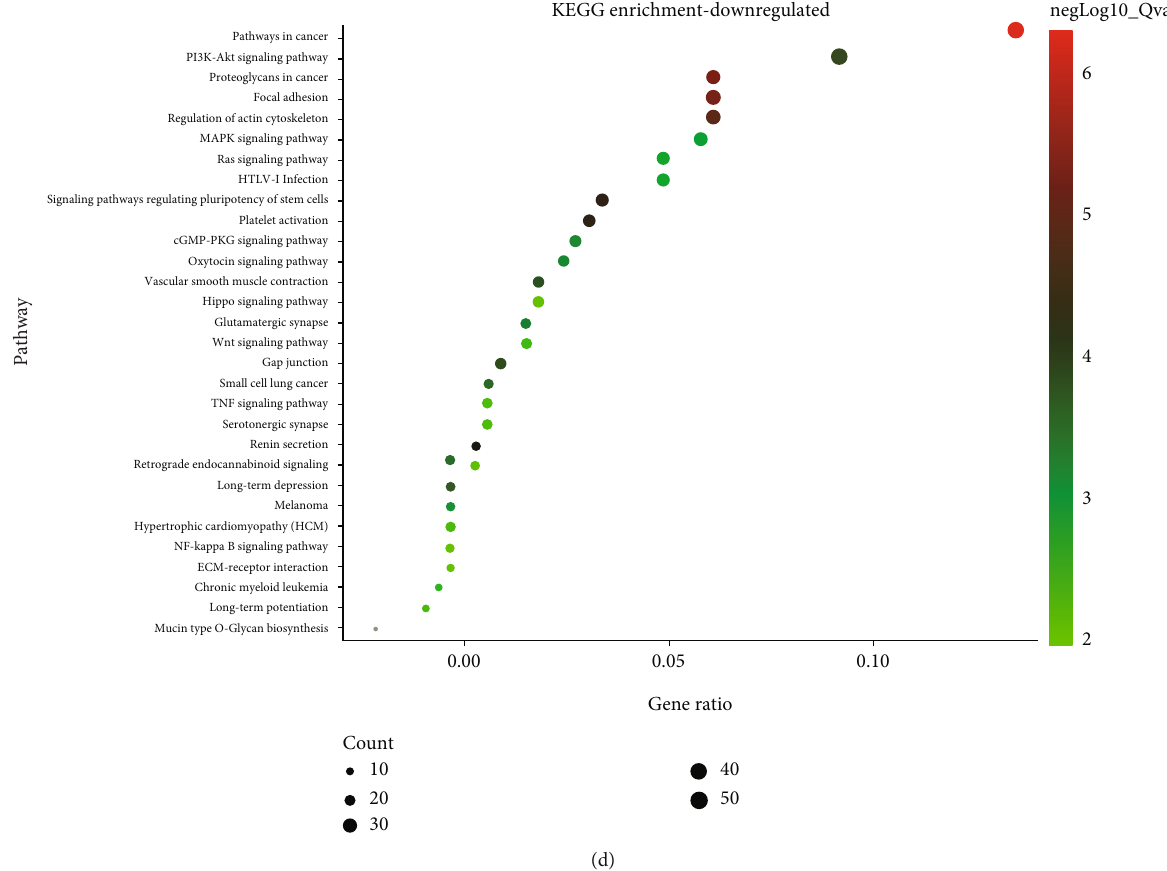
Figure 1: Functional enrichment of 1562 DEGs in lgCMN. (a) Volcano plot of DEGs. The red dots represent the upregulated genes, whereas the green dots represent the downregulated genes. The gray dots are genes without signi fi cant di ff erence in expression. Line threshold: Log ∣ FC ∣ >2 and adjusted P value < 0.05. (b) Gene Ontology enrichment of DEGs. (c and d) Top 30 signi fi cantly enriched pathways of downregulated and total DEGs demonstrated as bubble charts. The size of the bubble illustrates the gene count in each pathway, and the color symbolizes the enrichment degree. A Q value < 0.05 was considered statistically signi fi cant. DEGs: di ff erentially expressed genes; GO: Gene Ontology; KEGG: Kyoto Encyclopedia of Genes and Genomes; Q value = adjusted P value